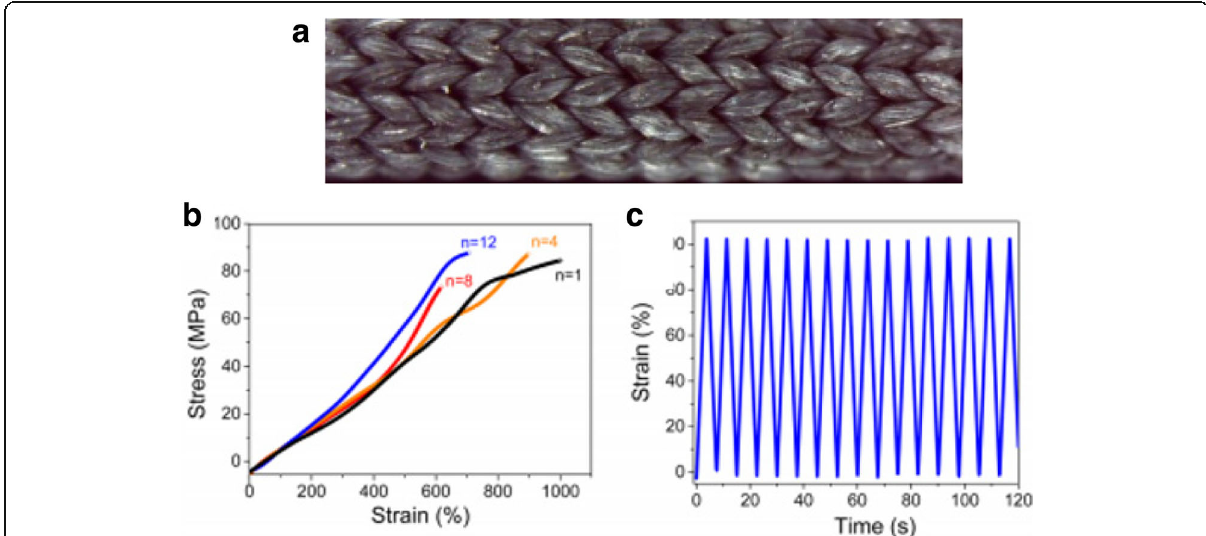
Fig. 38 SEM image of CNT/SPX8 knitted textile and the corresponding mechanical properties. a SEM image of CNT/SPX8 knitted textile. Adapted from [271]. b Stress – strain curves of the CNT textile material. Adapted from [271]. c Strain versus time for this textile, stretched for 1000 cycles at 0.2 Hz. Adapted from